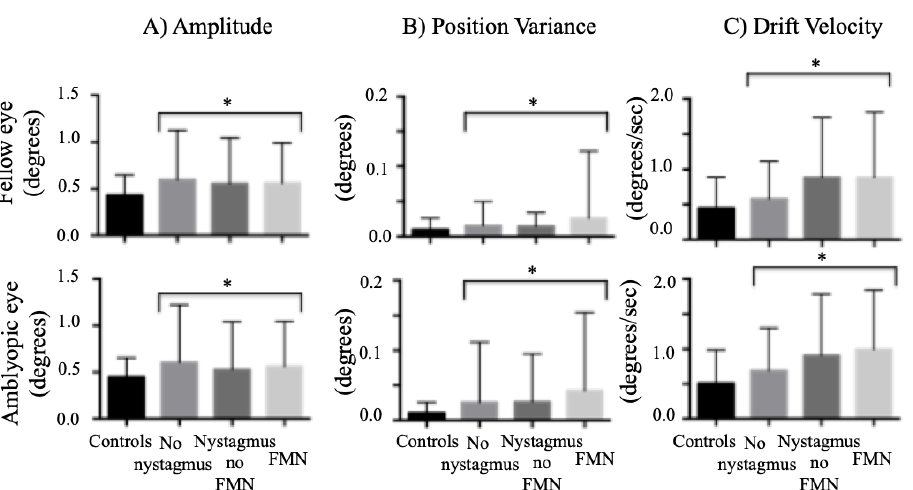
Fig. 4 : Mean and standard deviation of eye movement parameters of fixational saccade amplitude, position variance, and drift velocity in subjects across eye movement waveforms under both eyes viewing condition. Composite amplitude (A) of fixational saccades in controls and patients without nystagmus and quick phases of patients with nystagmus shows increased amplitude in both the fellow and amblyopic eye of amblyopes. Similarly, position variance (B) of drifts in controls and patients without nystagmus and slow phases of patients with nystagmus is also increased in both the fellow and amblyopic eye, although the increase is more pronounced in the amblyopic eye. The drift velocity (C) in controls and patients without nystagmus and slow phase velocities in patients with nystagmus is also increased in am- blyopes compared to controls. Those with and without nystagmus have greater velocity compared to controls. *=p<0.05, one way